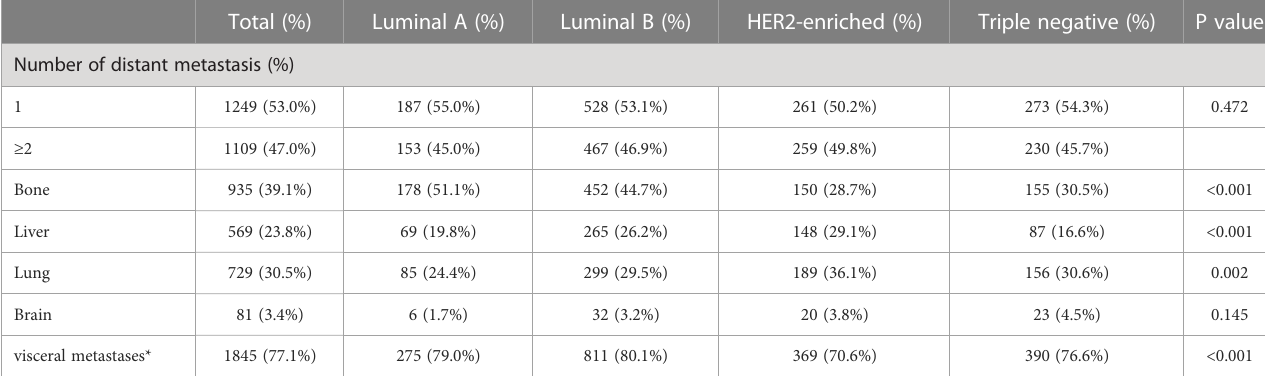
TABLE 3 Cumulative frequency of distant metastasis sites according to molecular subtypes. Total